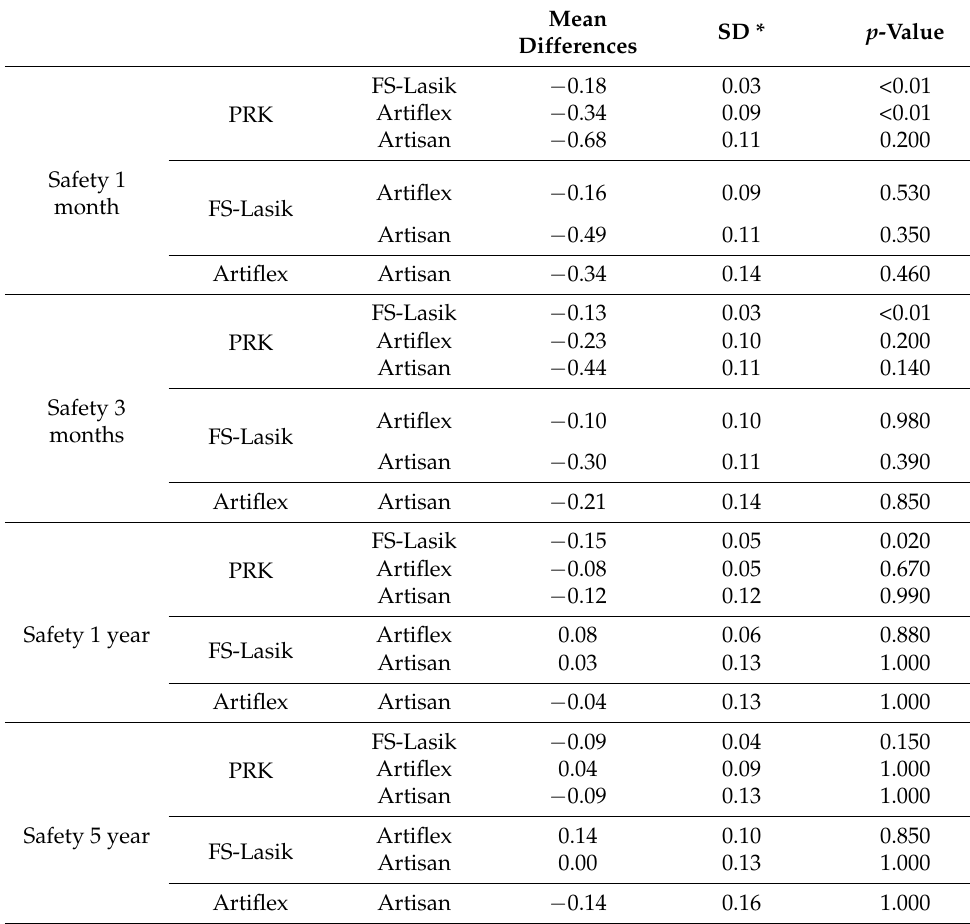
Table 4. Mean differences between surgeries techniques safety in the follow-up periods.